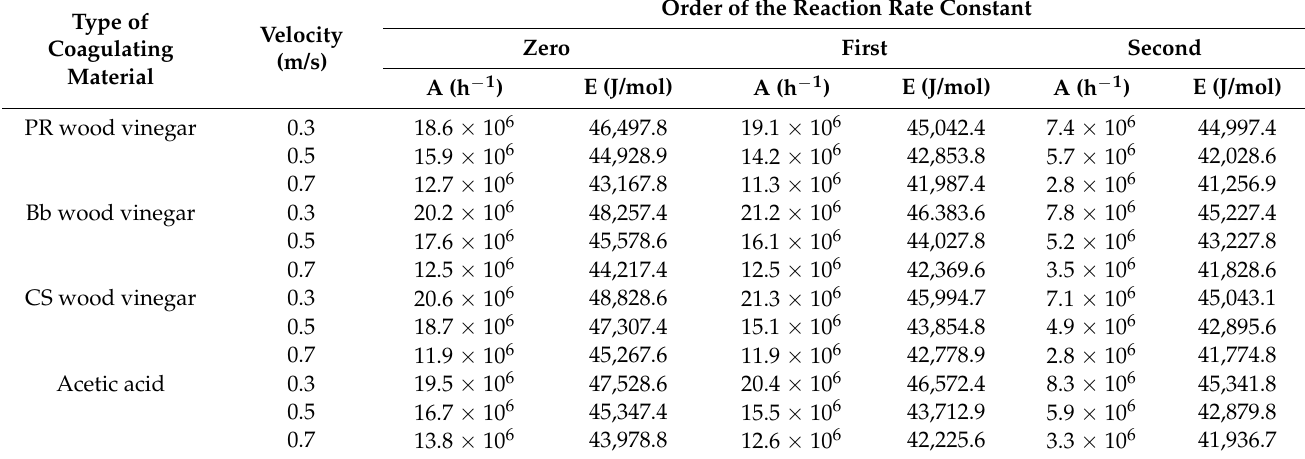
Table 3. The activation energy and frequency factor values of the expressed rate constant (PR = para rubber, Bb = bamboo, and CS = coconut